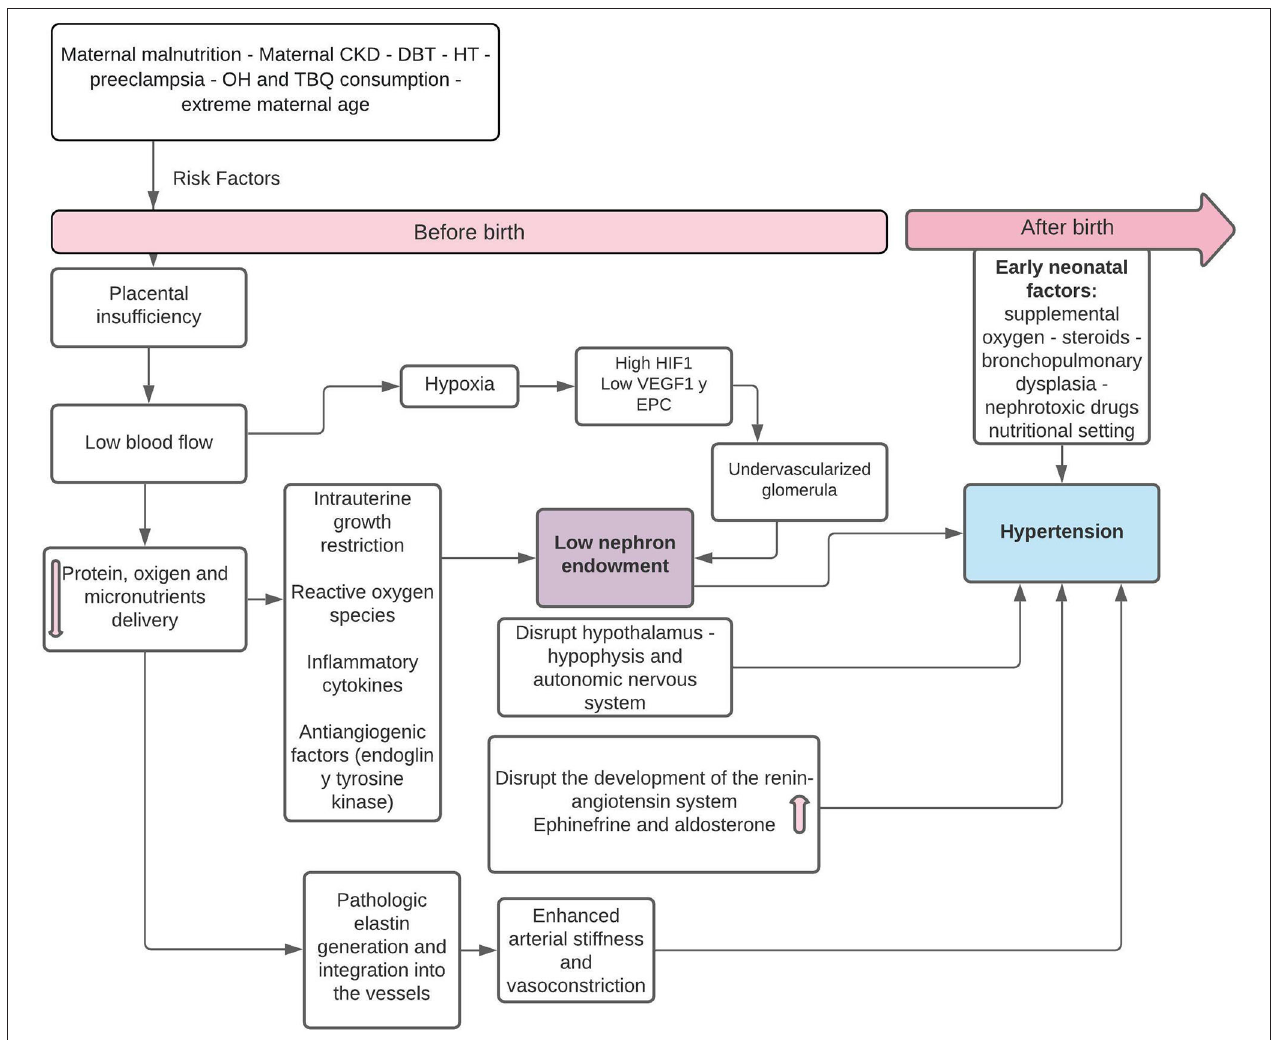
FIGURE 1 | Pathophysiology of fetal “programming” in SGA infants in relation to the decrease in the number of nephrons and postnatal HT. HIF-1, hypoxia-induced factor-1; SGA, small for gestational age; VEGF, vascular endothelial growth factor; EPC, neonatal endothelial progenitor cells. Modified from Stritzke et al. (9) and Crump et al. (